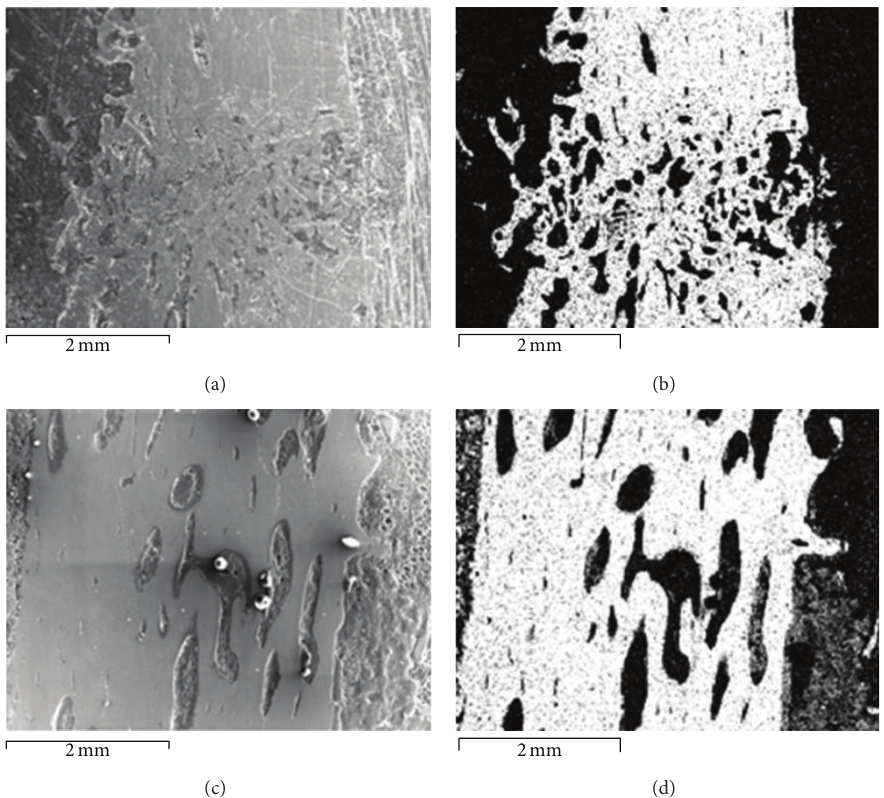
Figure 6: Bone regeneration in the intermediary area on day 75. Group 1 (upper row) and group 2 (lower row): (a, c) scans, × 20; (b, d) calcium distribution in the intermediary area by electron probe X-ray